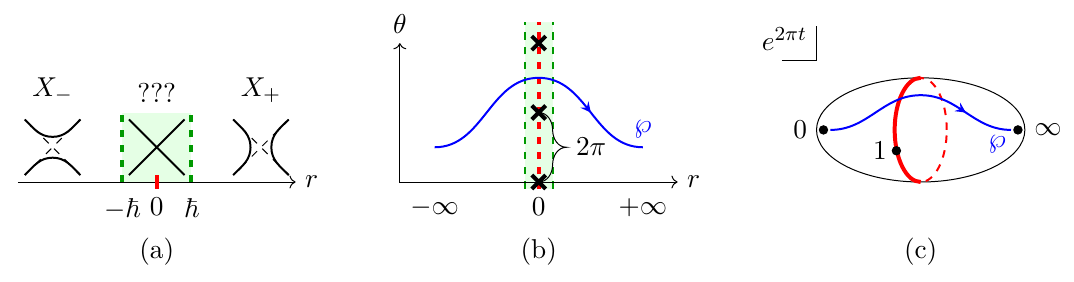
Figure 2 . Different representations of the path ℘ on the parameter space P . In all these three representations the path travels between Higgs branch descriptions through a narrow region around values r = 0 , | e 2 πt | = 1 where a Coulomb branch description of the IR physics is in